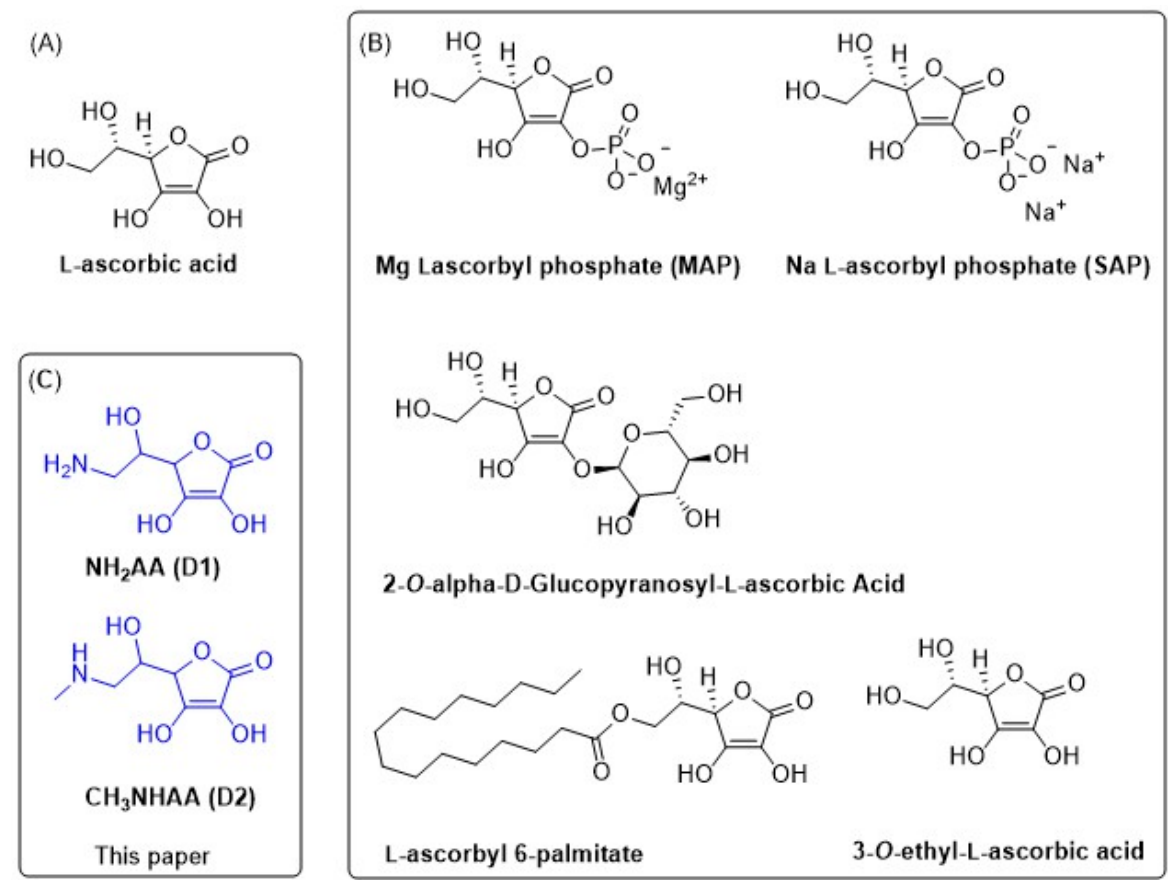
Figure 1. Structures of L-ascorbic acid ( A ), widely known and previously studied derivatives of L- ascorbic acid ( B ) and herein studied 6-amino-6-deoxy-L-ascorbic acid (NH 2 AA, ( C )) and N -methyl- 6-amino-6-deoxy-L-ascorbic acid (CH 3 NHAA, ( C )).